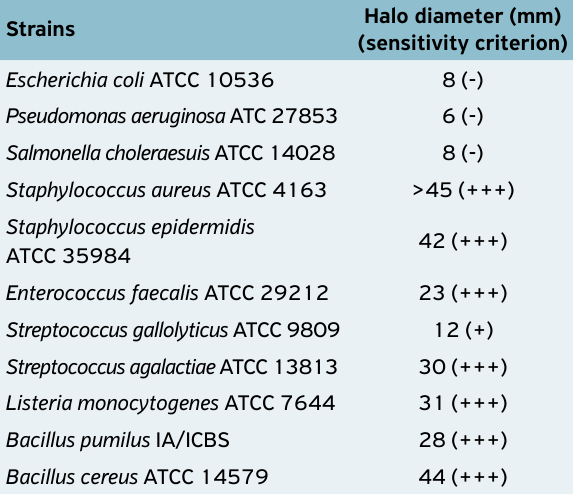
Table 2. Results of the in vitro antimicrobial activity test of essential oil of dried leaves of Eucaplyptus staigeriana (EO dl ES) against gram‑negative and gram‑positive strains.